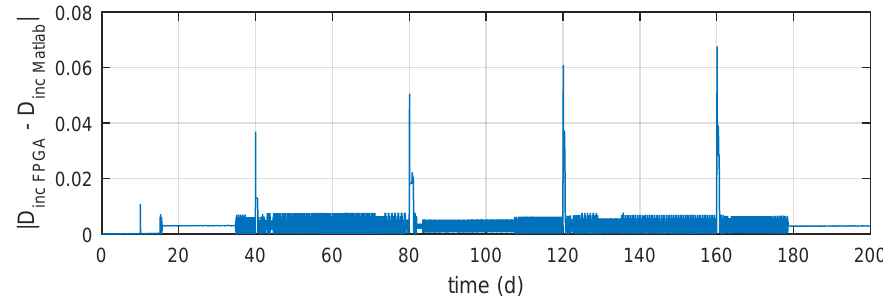
Figure 22. Truncation error in DTSTC implementation.